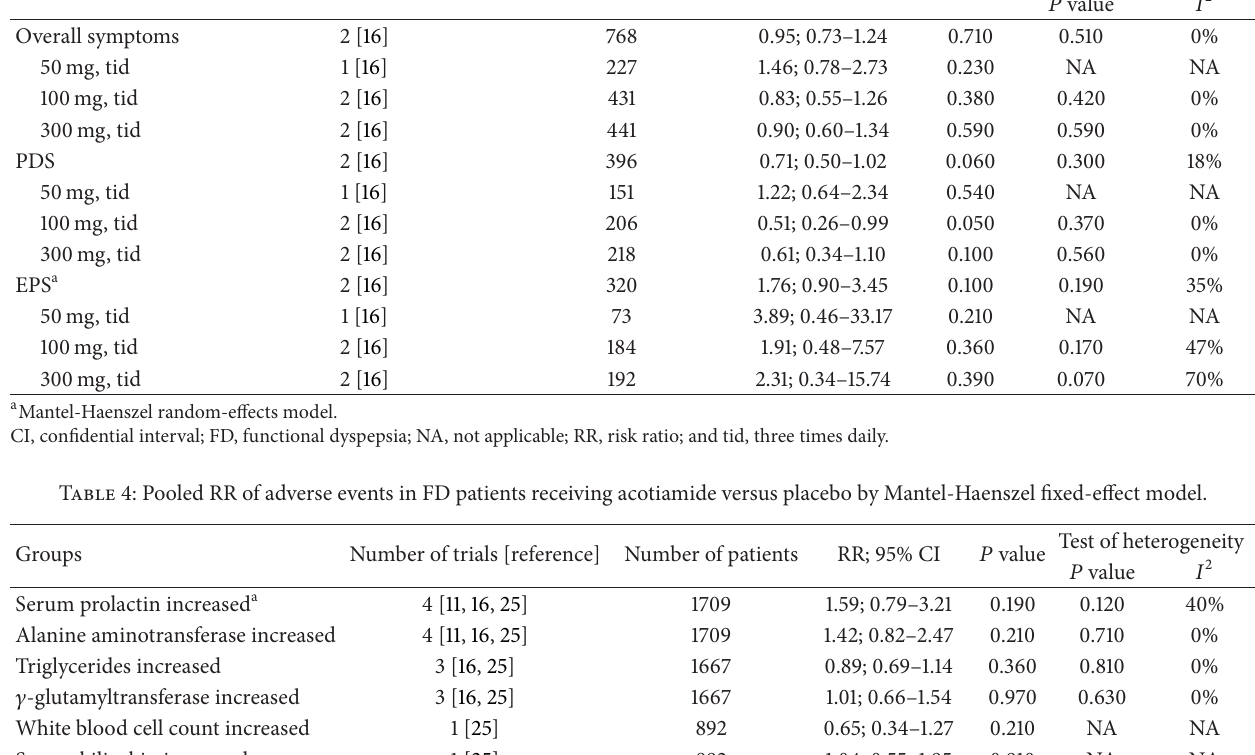
Table 3: Pooled RR of acotiamide versus placebo for nonresponders by Mantel-Haenszel fixed-effect model. Groups or subgroups